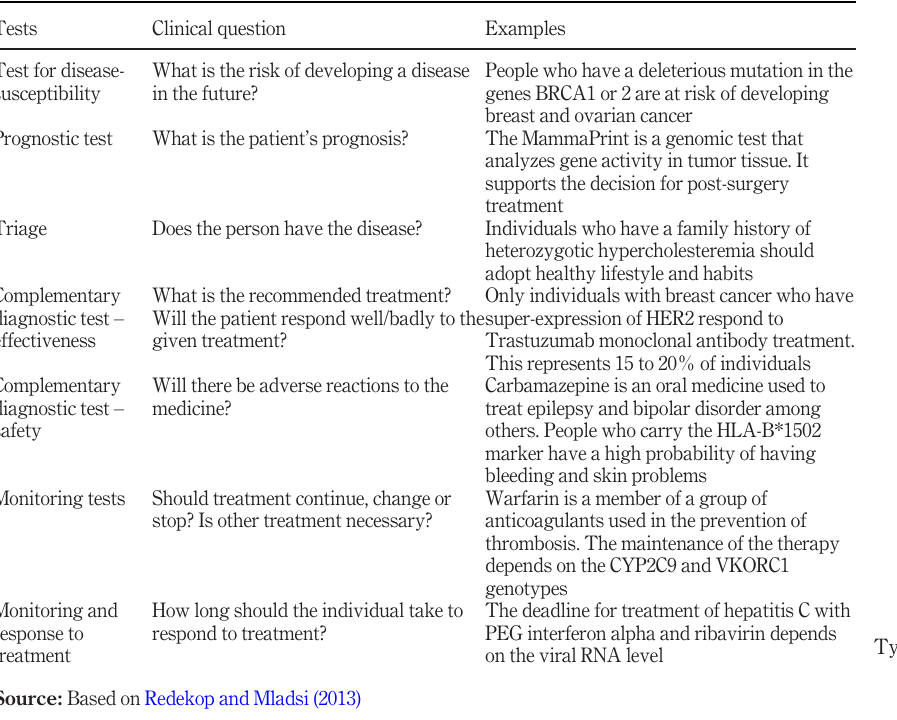
Table 1. Types of test,